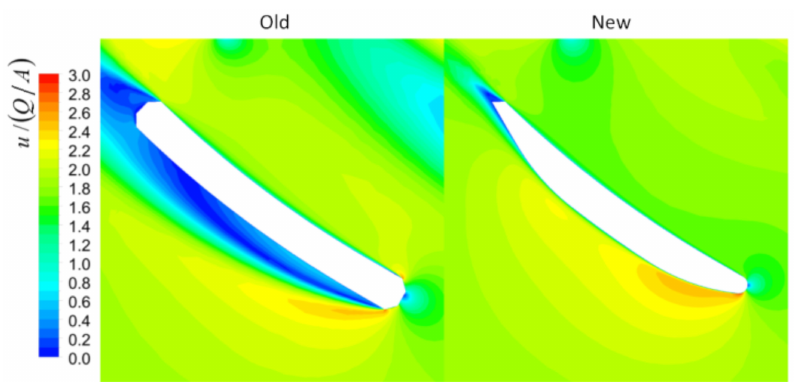
Figure 10. Velocity at the tandem cascade horizontal plane in case 1 hydraulic turbine functions of the inlet area of the spiral case and the turbine